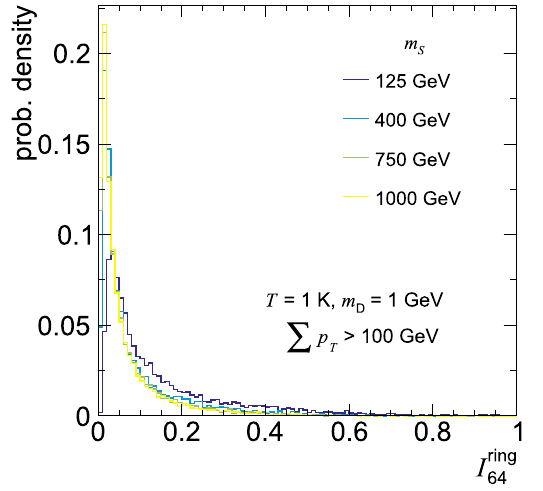
Fig. 16 Isotropy distributions are shown for different SUEP media- tor masses on the left and for different temperatures on the right. The isotropy is calculatedfor ring geometry with segmentation64 for gener- ator level tracks. Tracks are defined as status = 1 charged particles with